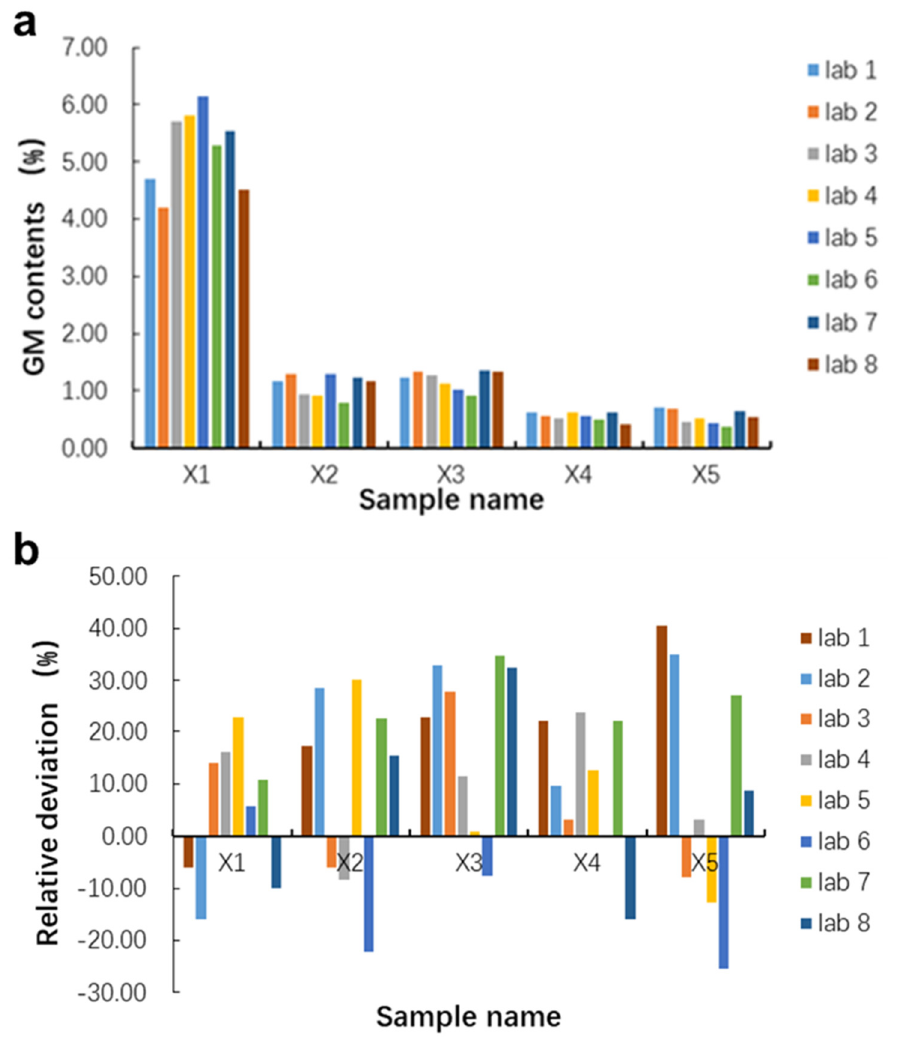
Figure 3. Relative deviation of the quantification results of five blind samples in the inter-laboratory study. ( a ) Quantified GM contents of blind samples in each participated lab. ( b ) The relative deviations of each blind sample in eight